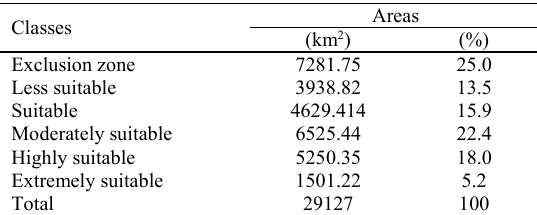
Table. 6: The area of final land suitability map classes obtained by fuzzy analytic hierarchy process Classes